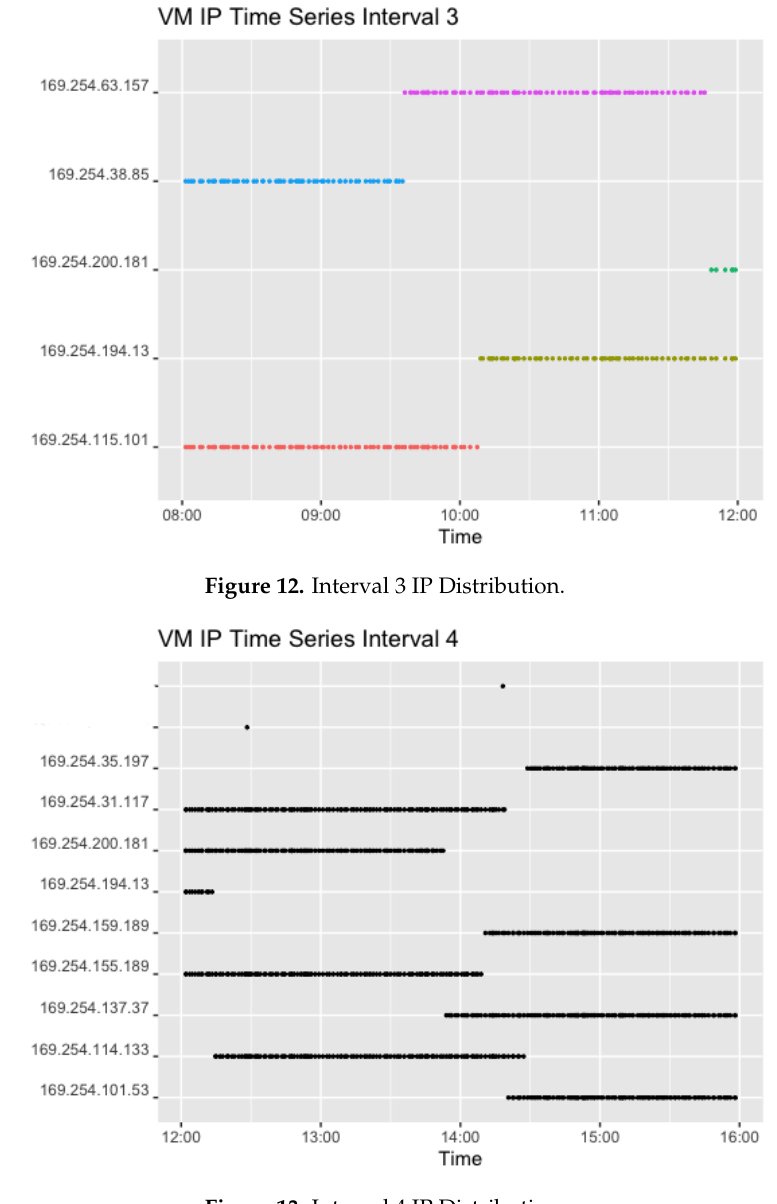
Figure 13. Interval 4 IP